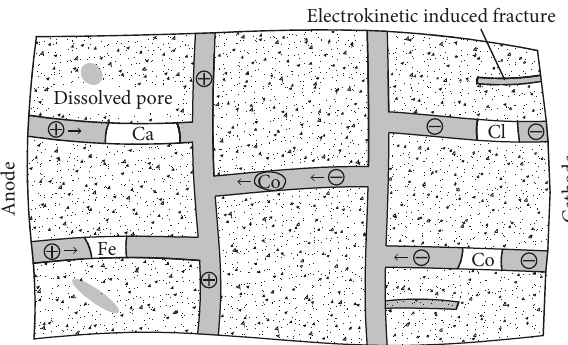
Figure 9: Schematic diagram of the mechanism by which an- thracite was modified by the electrochemical